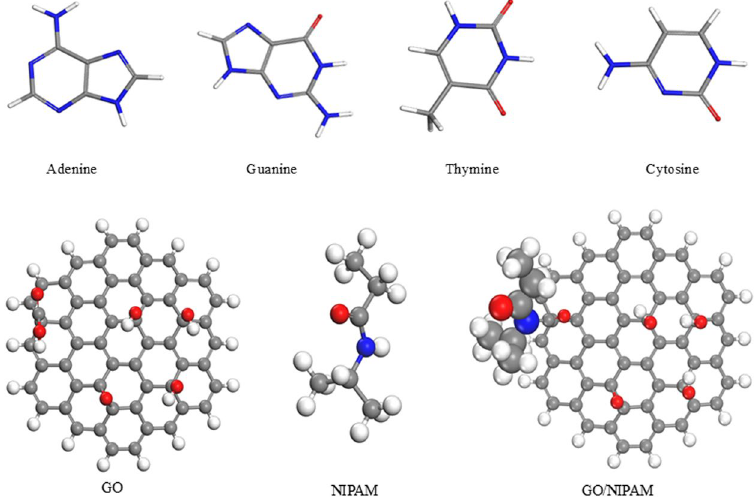
Figure 1. The optimised structure of nucleobases, GO, NIPAM, and